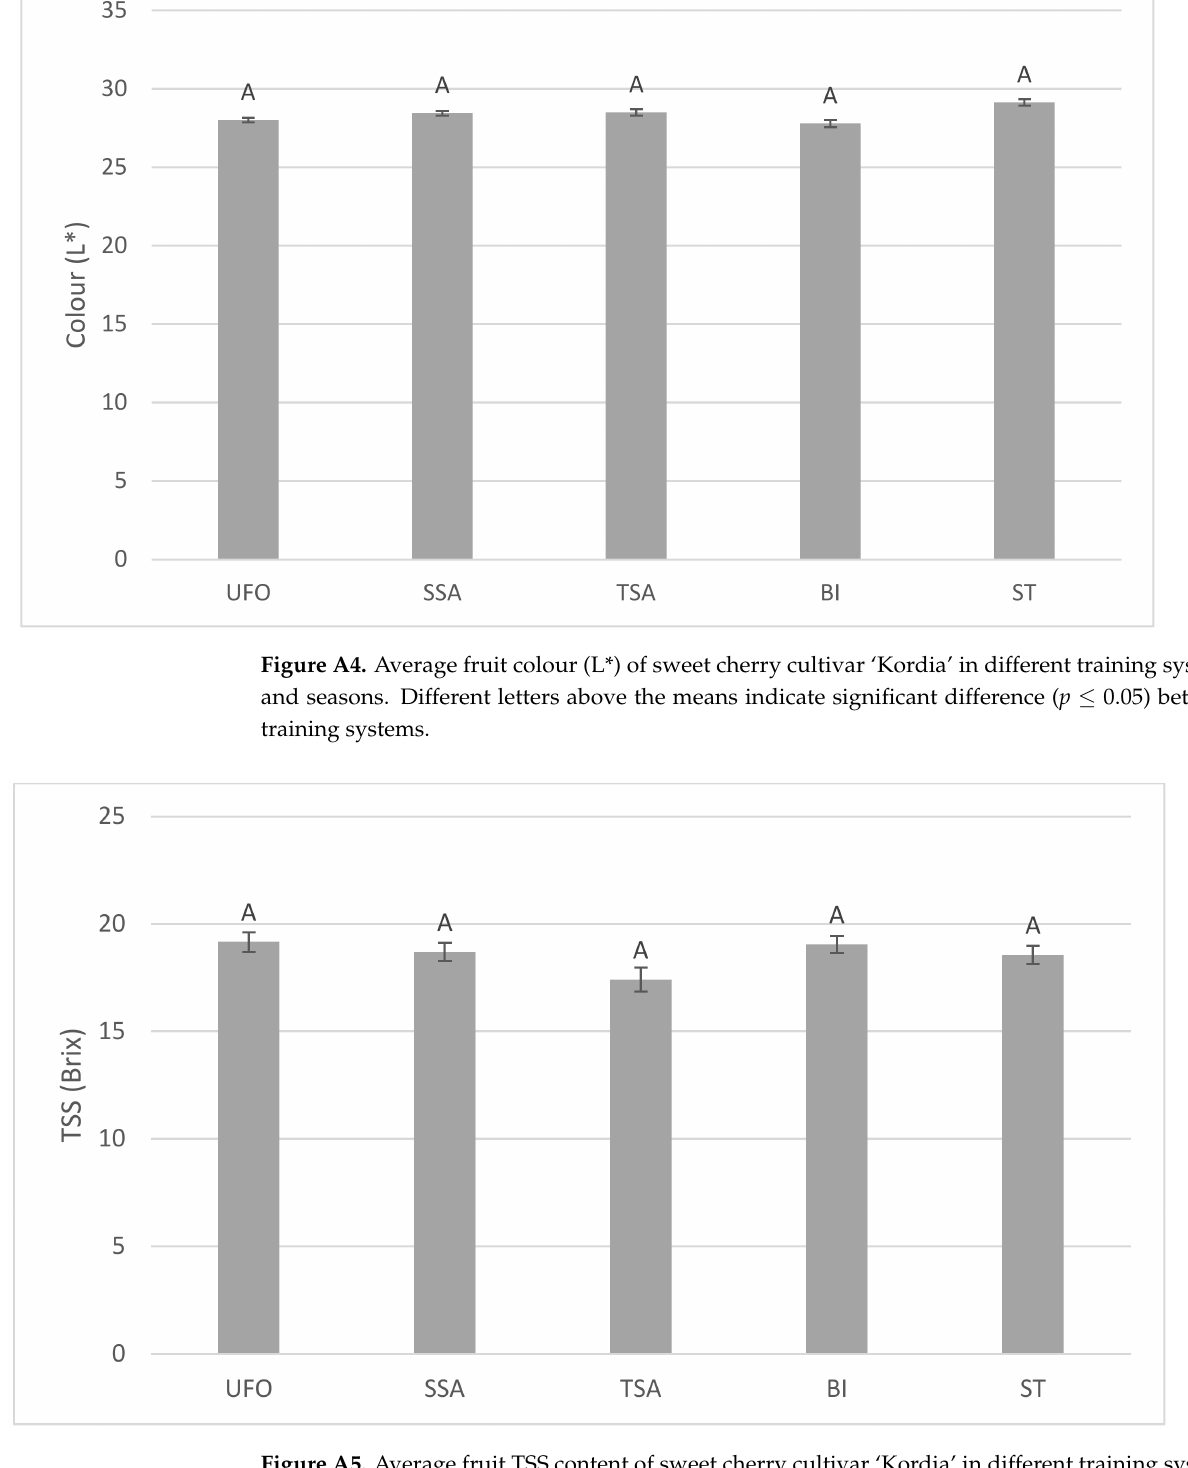
Figure A5. Average fruit TSS content of sweet cherry cultivar ‘Kordia’ in different training systems and seasons. Different letters above the means indicate significant difference ( p ≤ 0.05) between training